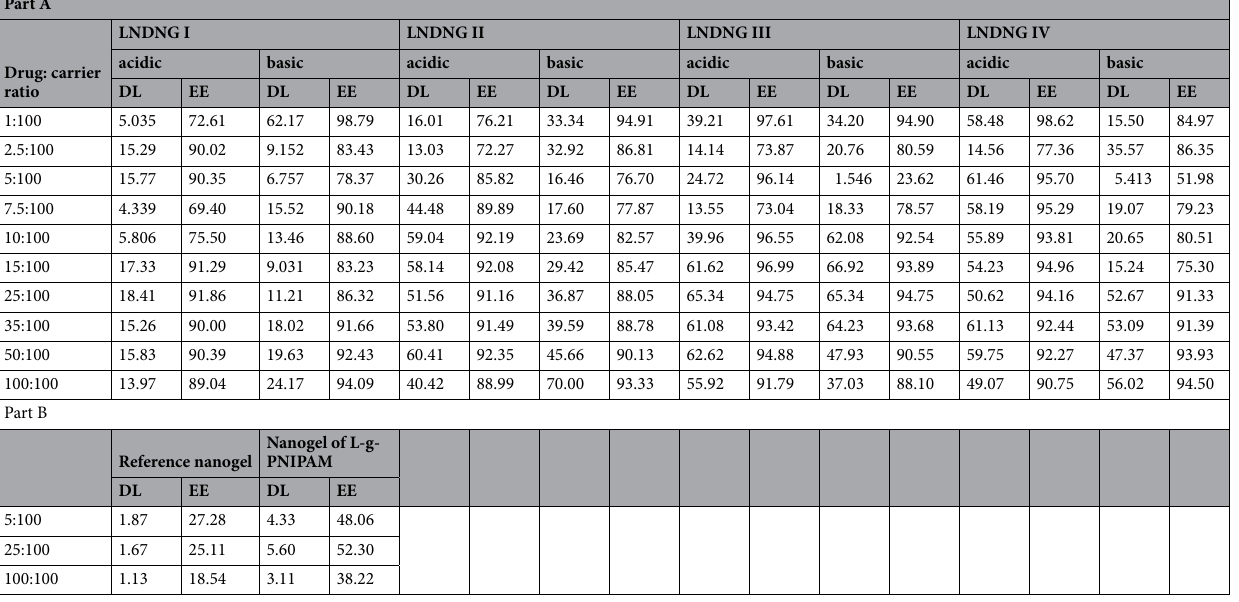
Table 4. The results obtained on CUR-loading content and encapsulation efficiency by various